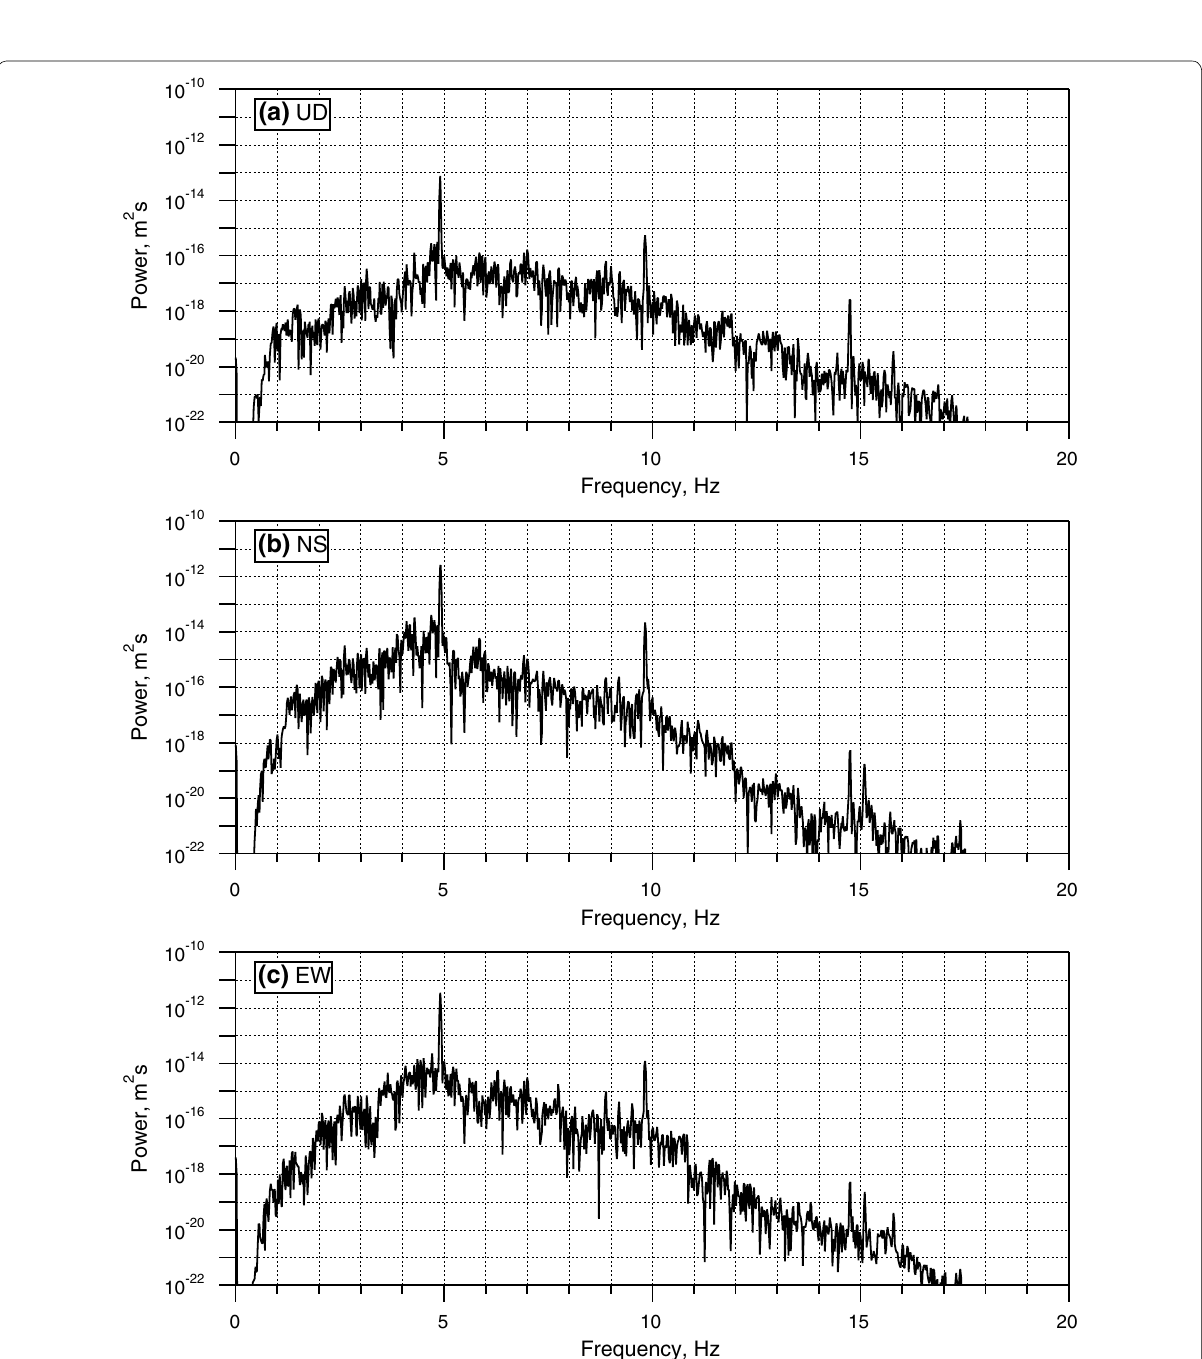
Fig. 6 Power spectra of the ground displacement recorded by a seismometer. a Up–down component, b north–south component and c east– west component. This was acquired while the VLBI antenna was